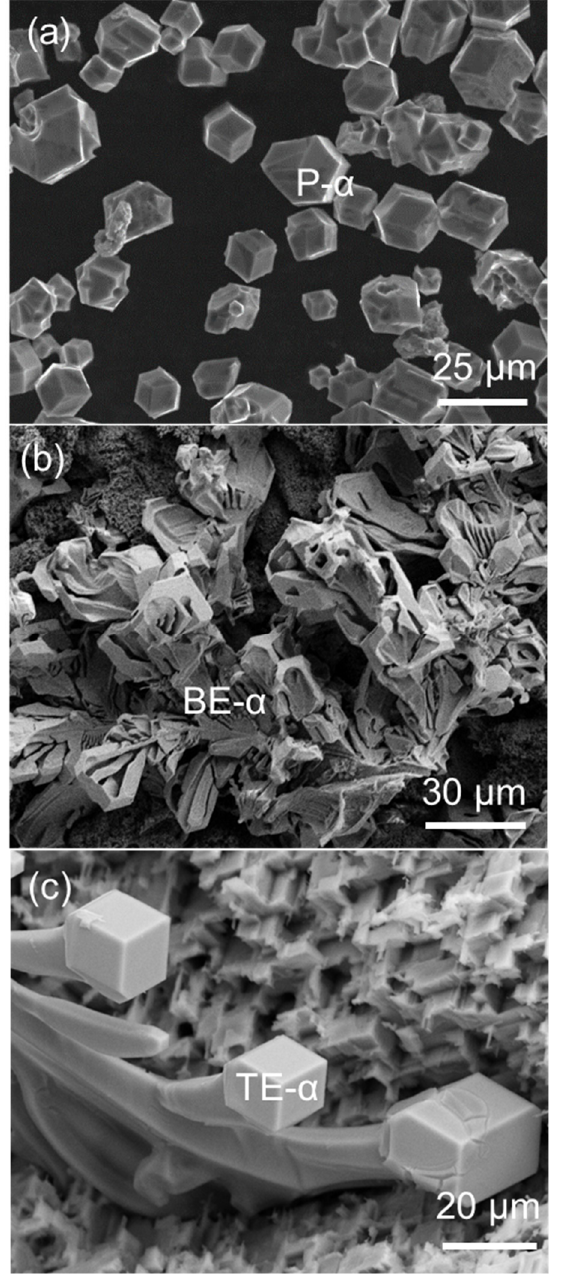
Figure 5. Different morphologies of α -Al 15 (Fe, Mn) 3 Si 2 : ( a ) extracted primary α -Al 15 (Fe, Mn) 3 Si 2 (denoted as P- α ) with a compact morphology in Al-5Mg-2Si-0.7Mn-1.3Fe alloy solidified at 3.5 K/s [31]; ( b ) binary eutectic α -Al 15 (Fe, Mn) 3 Si 2 (denoted as BE- α ) with a Chinese script morphology in Al- 3Mg-2Si-0.7Mn-1.3Fe alloy solidified at 3.5 K/s. The sample was deep-etched; and ( c ) ternary eutectic α -Al 15 (Fe, Mn) 3 Si 2 (denoted as TE- α ) with compact morphology in Al-2Si-0.7Mn-1.3Fe alloy solidified at 0.01